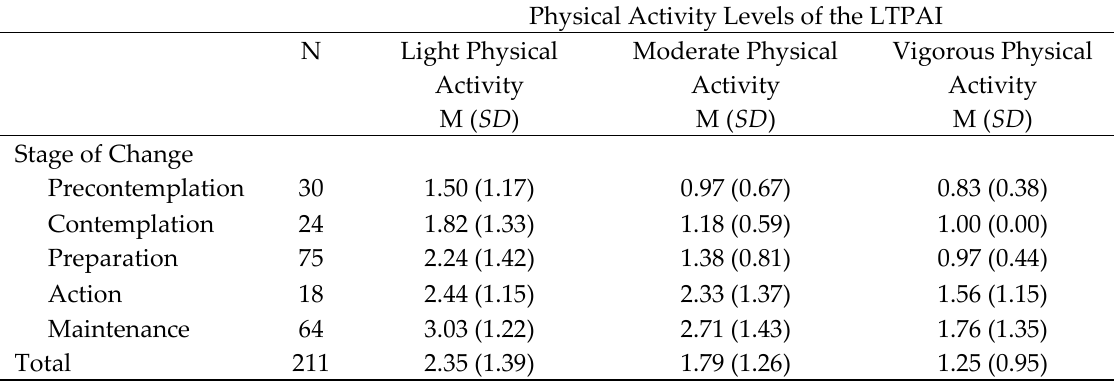
Table 1. Means and Standard Deviations of Physical Activity Levels of the LTPAI by Physical Activity Behavior Stages from the Physical Activity Stages of Change Instrument